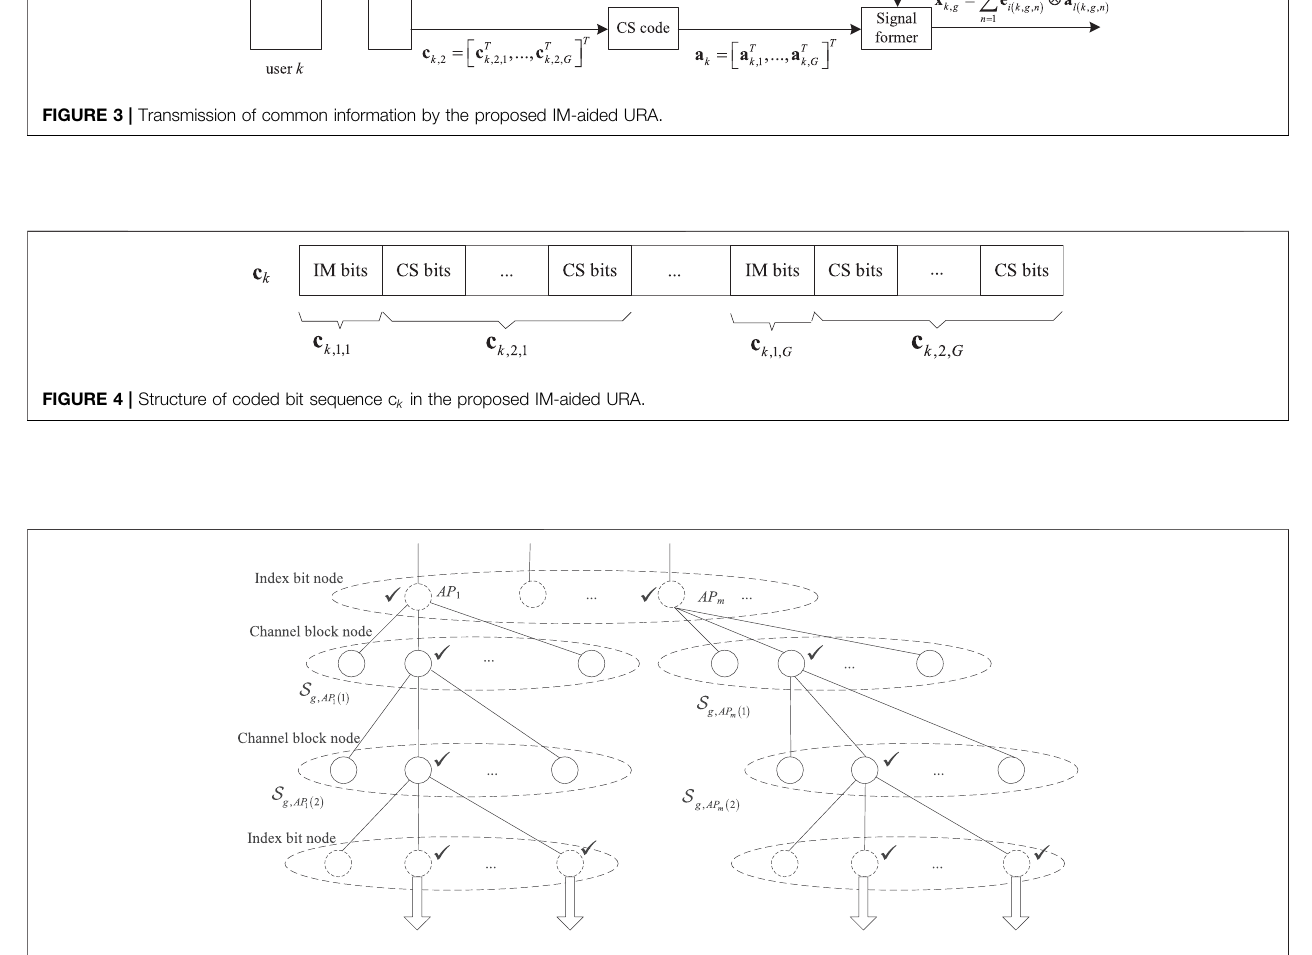
FIGURE 5 | Illustration of the modi fi ed outer tree decoder in the g th group with N a (cid:1) 2. The notation “ ✓ ” denotes this node passes the parity-check.